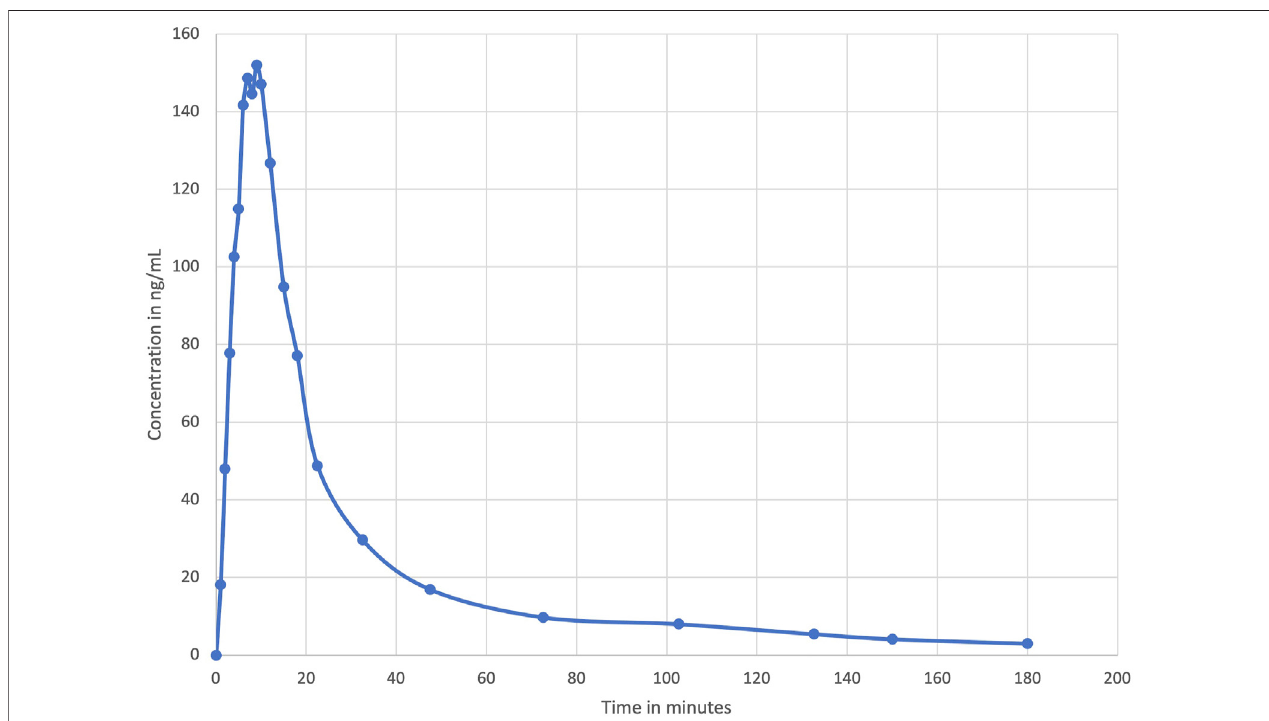
FIGURE 3 | Mean plasma levels of THC during and after smoking a single 3.55% THC marijuana cigarette obtained by Huestis et al. (1992).